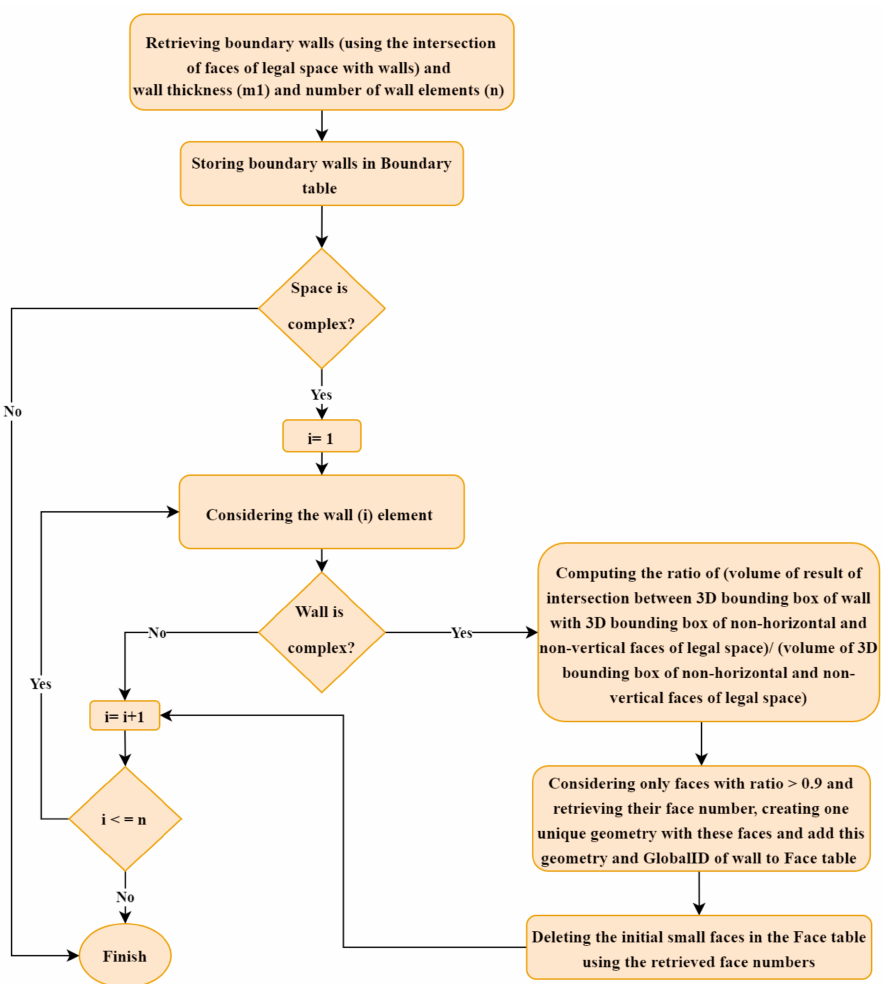
Figure 15. A procedure for converting all the small faces associated with the roof element to a single